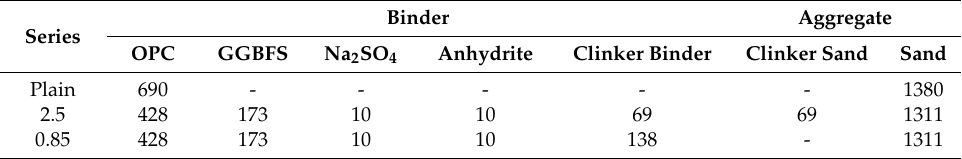
Figure 1. Grain size analysis results of GGBFS. Table 2. Mix proportions of mortar (in kg/m 3 , W/B = 0.4).